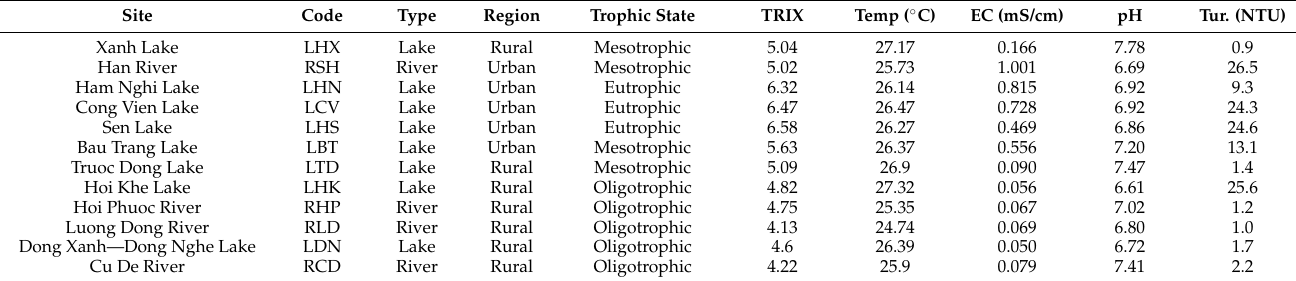
Figure 1. The study area. Table 1. Water quality characteristics at 12 sampling Table 1. Water quality characteristics at 12 sampling sites.